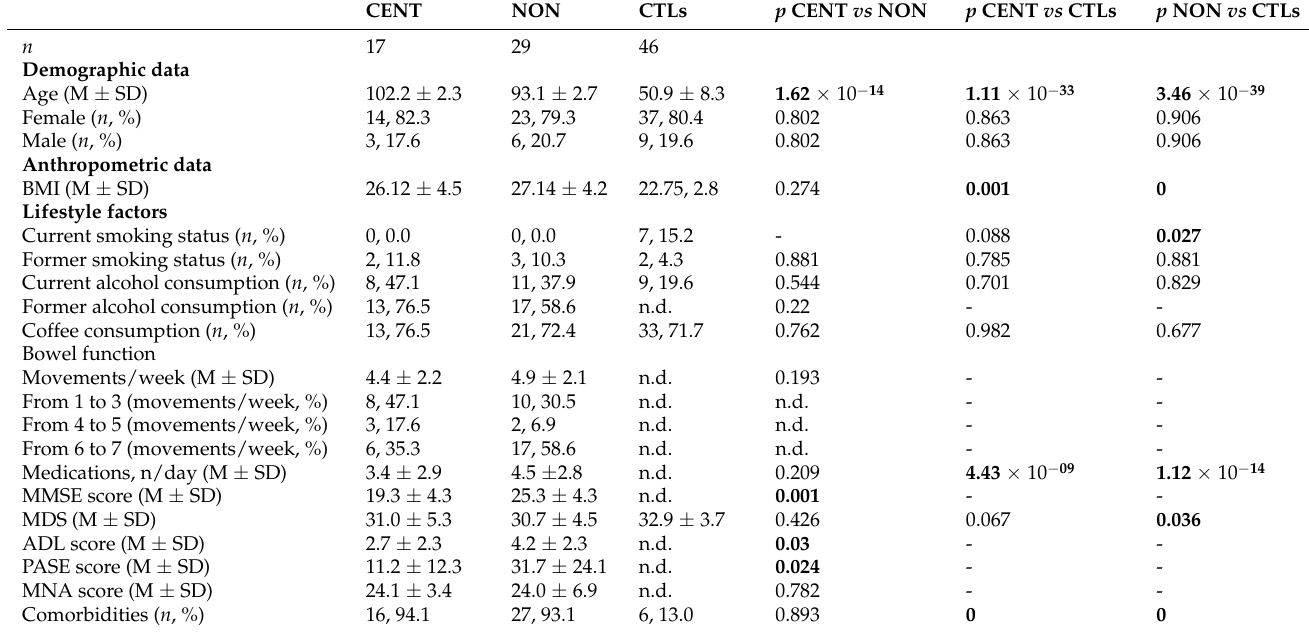
Table 1. Clinical and lifestyle data of CENT and CTLs